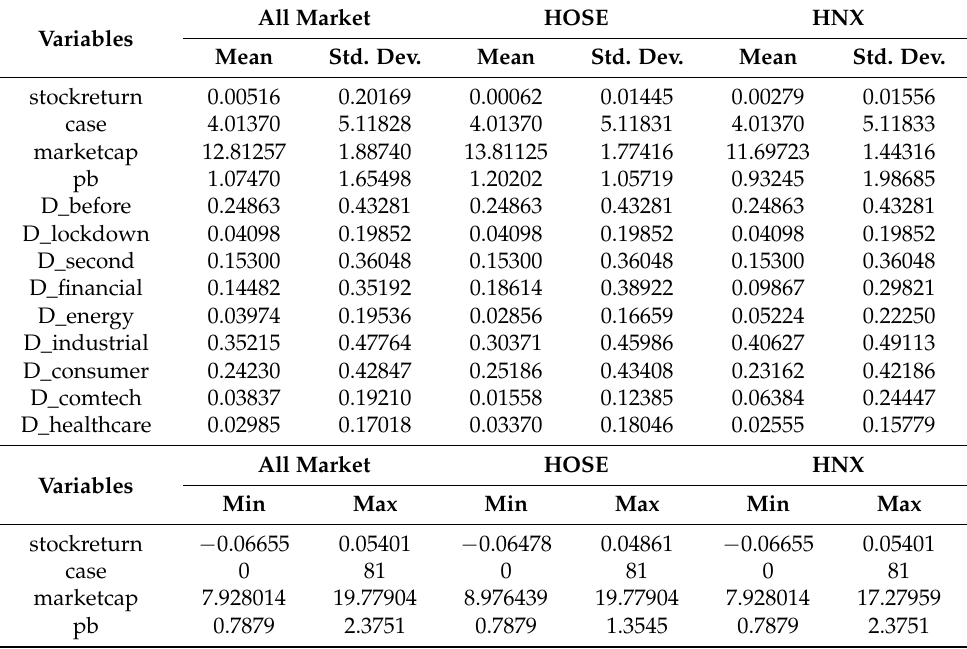
Table 2. Summary of descriptive statistics (Source: Authors’ calculation and compilation).